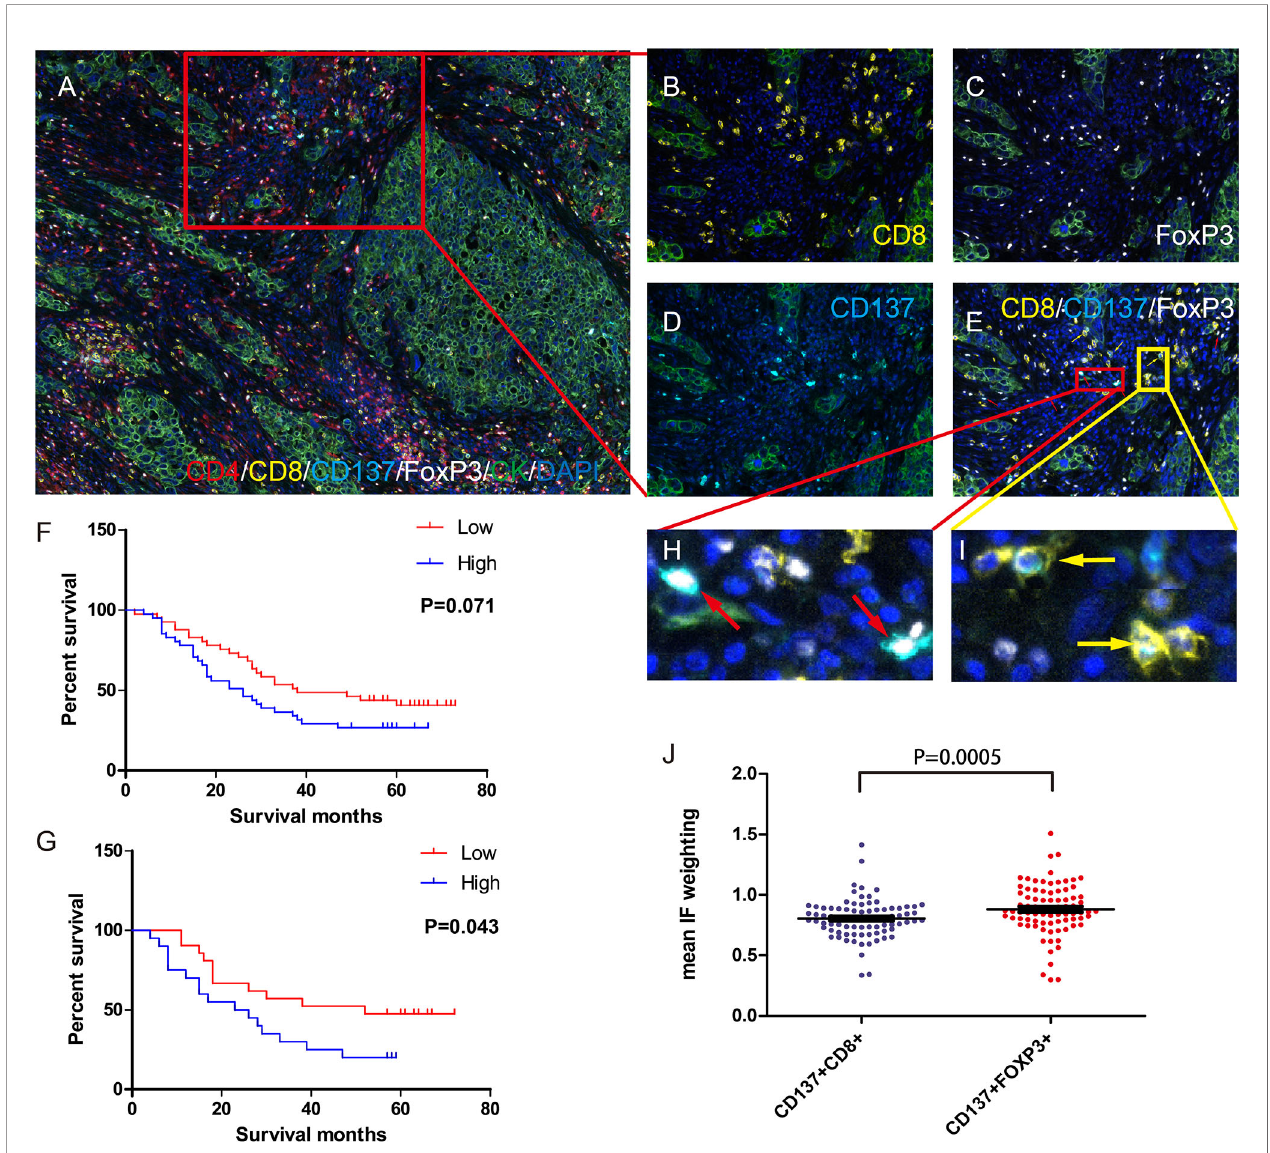
FIGURE 5 | Density of Foxp3+ and CD137+FOXP3+ cells in the tumor microenvironment and its correlation with prognosis. (A) Immune cells in the tumor microenvironment of a TMA core (20×). Magni fi ed view of the red box: CD8+ T cells (B) Foxp3+ cells (C) CD137+ cells (D) and double-positive cells. (E) CD137+ CD8+ cells are indicated by the yellow arrows, and CD137+Foxp3+ cells are indicated by the red arrows. (F) Impact of CD137+Foxp3+ cell density on patient OS. Dichotomization was based on the median; patients in the low-density group are indicated by the red line, and patients in the high-density group are indicated by the blue line. Log-rank P values are shown for each graph. (G) Correlation between CD137+Foxp3+ cell density and OS in patients with a high number of in fi ltrating CD137+CD8+ cells in the tumor microenvironment. CD137+CD8+ cell dichotomization was also based on the median. (H, I) IF intensity of CD137+FoxP3+ cells and CD137+CD8+ cells. (J) The mean IF intensity weighting of CD137 in CD137+CD8+ cells and CD137+FoxP3+ cells in TMA cores from 82 lung cancer patients. Differences are indicated as P values (paired t test). The error bars represent the